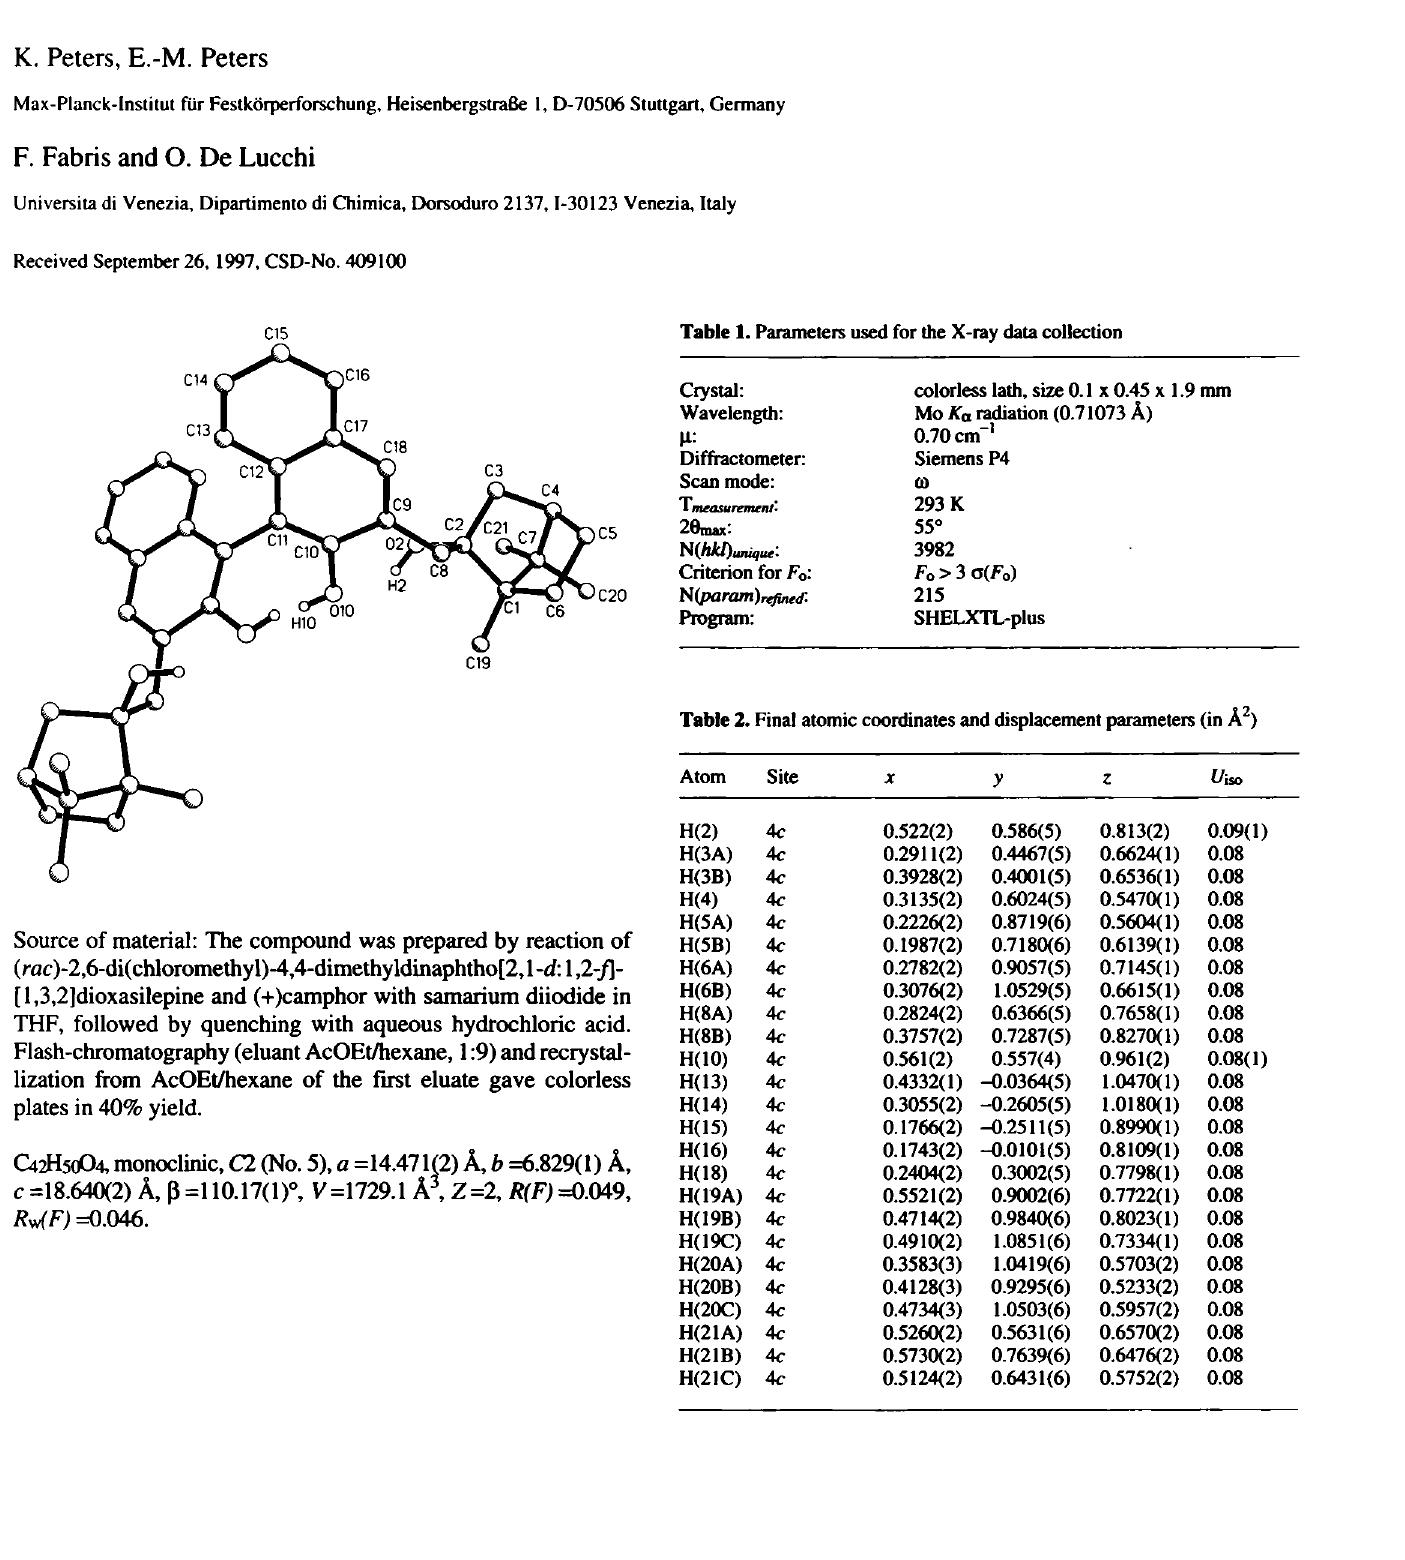
Table 1. Parameters used for the X-ray data collection